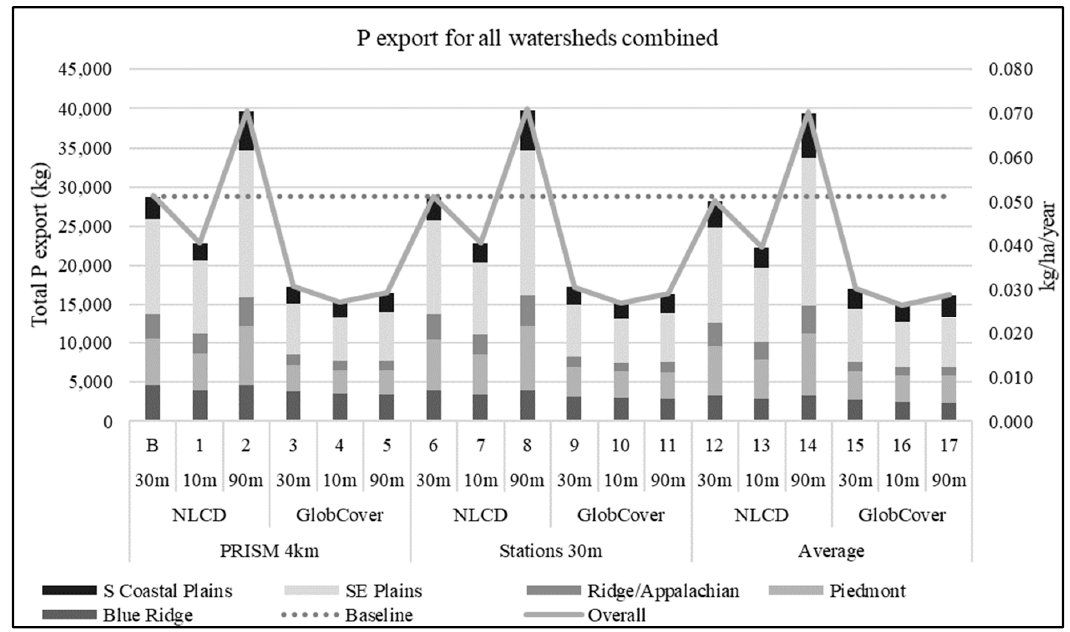
Figure 5. Total and relative phosphorus export for all scenarios aggregated from all watersheds. The bars show the total phosphorus export (kg) broken down by physiographical regions, the line provides the overall average of relative phosphorus export (kg/ha/year), and the dotted line displays the total export yielded by the Baseline (kg).